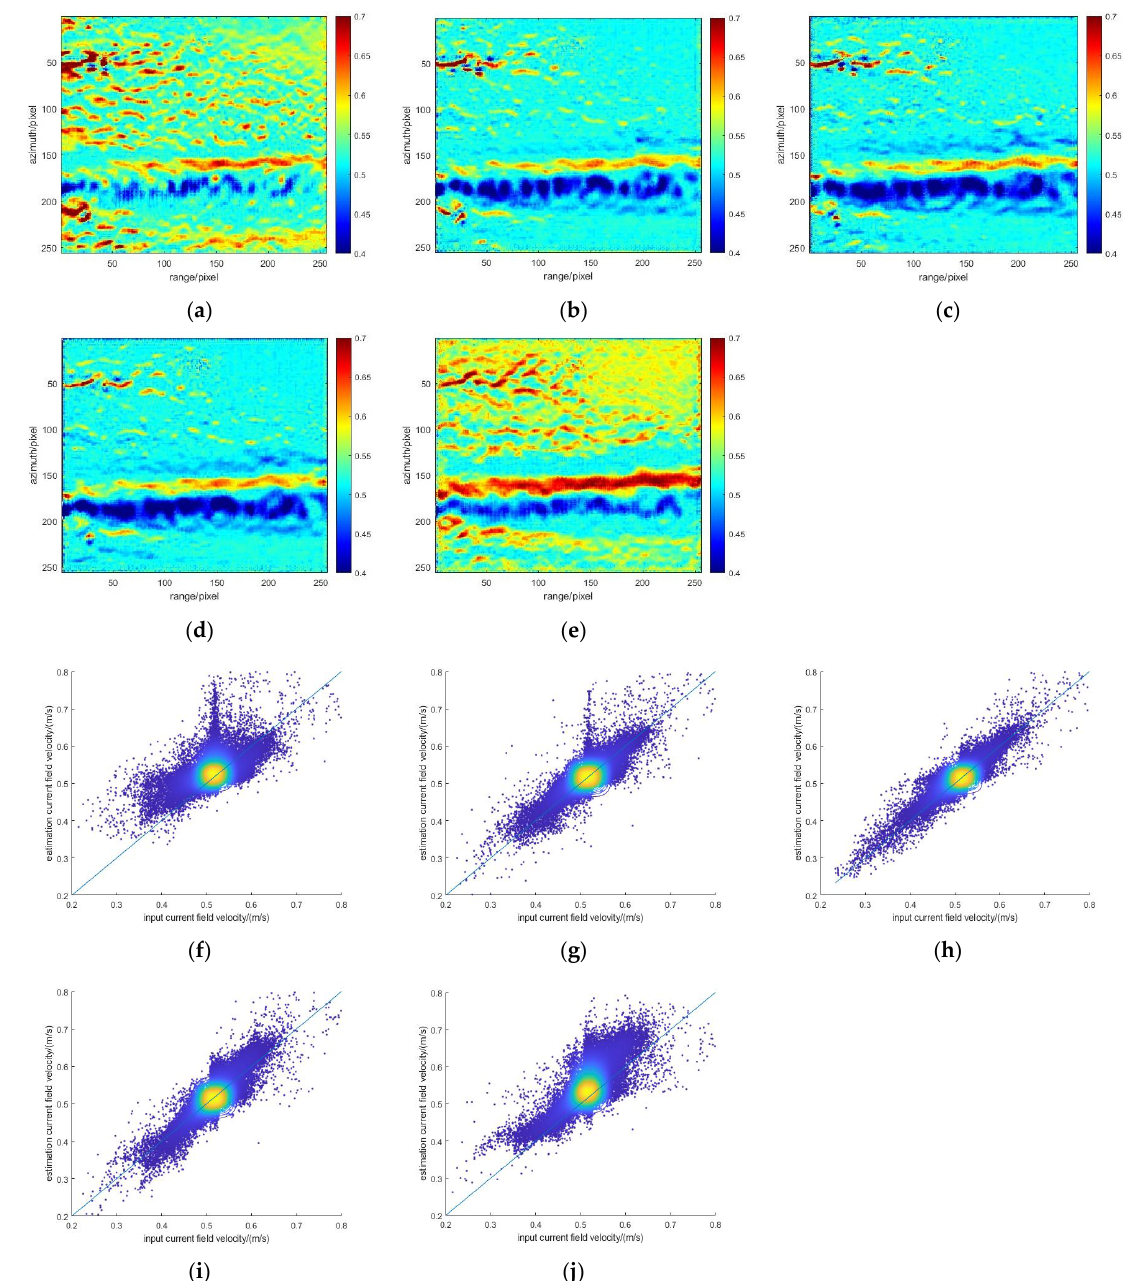
Figure 17. The estimation velocity of ocean surface currents under the different incident angles from ( a – e ): ( a ) 13°, ( b ) 28°, ( c ) 35°, ( d ) 43°, and ( e ) 50°. The scatter density map between the estimation velocity of ocean surface currents and the control group velocity of the input ocean surface currents under the different incident angles from ( f – j ): ( f ) 13°, ( g ) 28°, ( h ) 35°, ( i ) 43°, and ( j ) 50°. Table 11. Statistics of the estimation results under different incident angles.